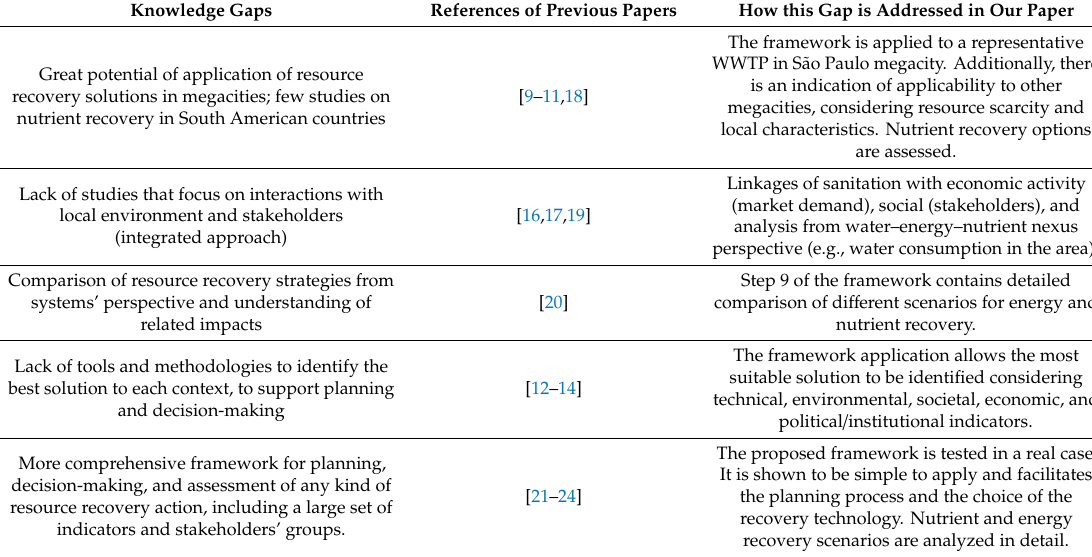
Table 1. Identified knowledge gaps with key journal paper references and how these gaps are directly addressed by the present